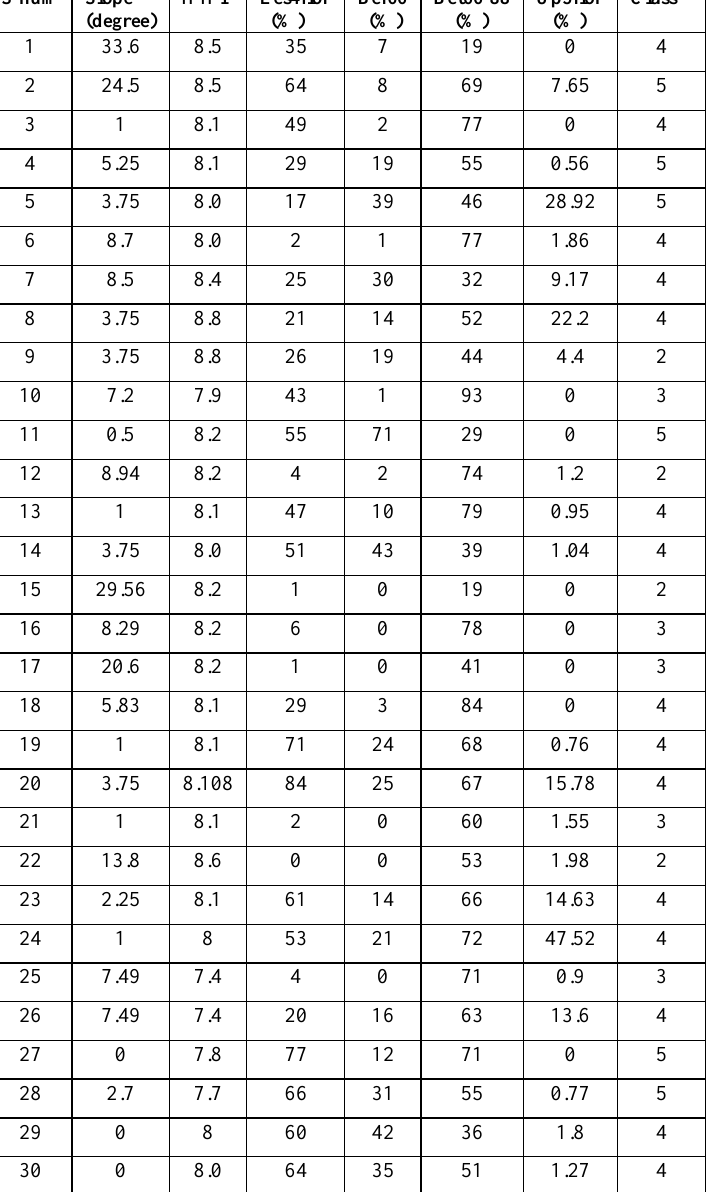
Table 1. Information table of 30 randomly selected